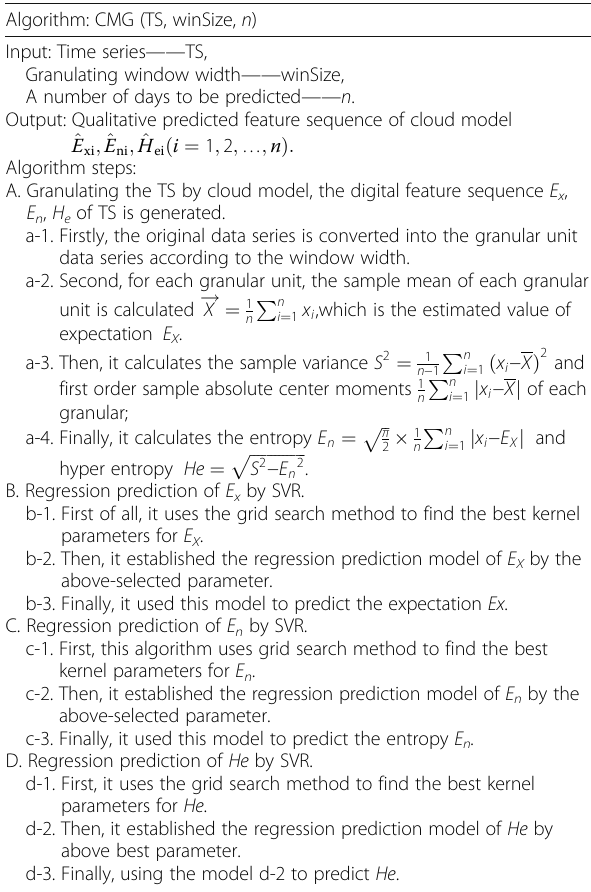
Table 3 CMG algorithm description Algorithm: CMG (TS, winSize, n